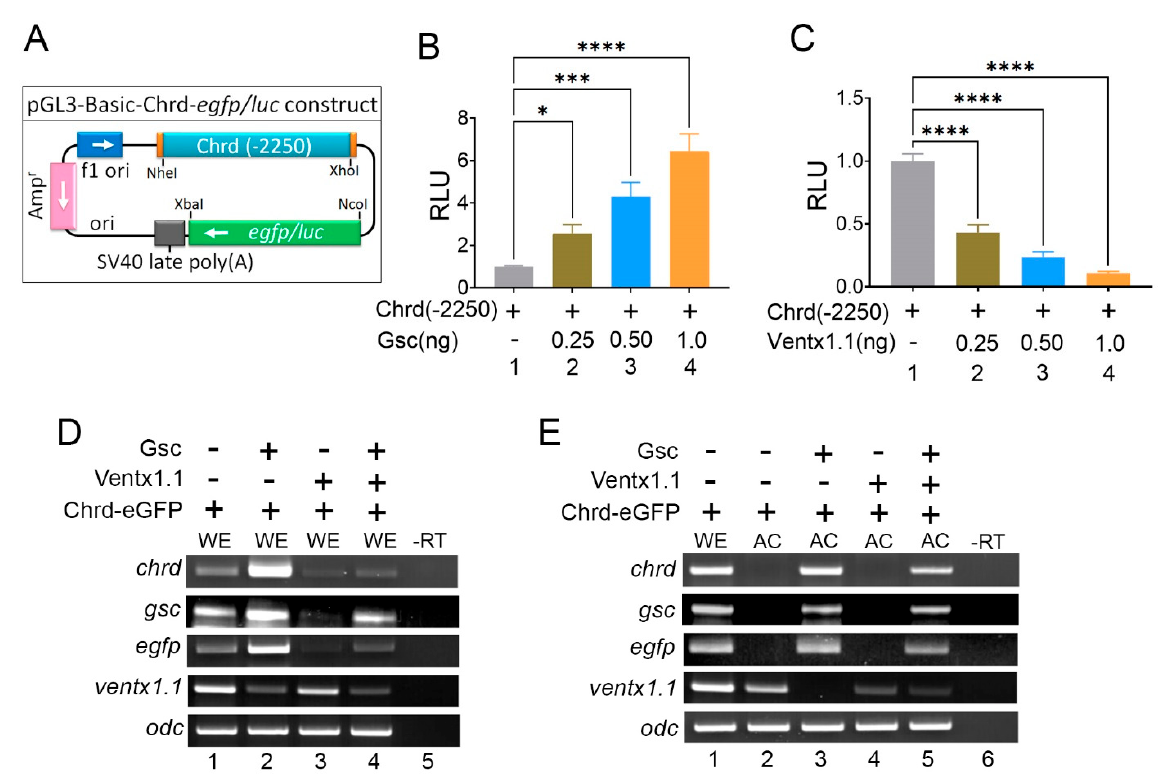
Figure 1. Ectopic expression of Gsc and Ventx1.1 differentially regulates the dorsal mesoderm (organizer) gene expression during gastrula. ( A ) The cloned chrd( - 2250) promoter mapped into Pgl3 luc/eGFP vector. ( B , C ) The Xenopus embryos were injected with Gsc ( B ) and Ventx1.1 ( C ) (1 ng/embryo) at the one-cell stage. The reporter assay was performed at stage 11 in whole embryos (WEs). ( C , D ) To examine the endogenous expression, embryos were co-injected with Gsc and Ventx1.1 (1 ng/embryo) at the one-cell stage. RT-PCR was performed at stage 11 in Wes ( D ) and ACs ( E ). -RT referred to control reaction without reverse transcriptase.